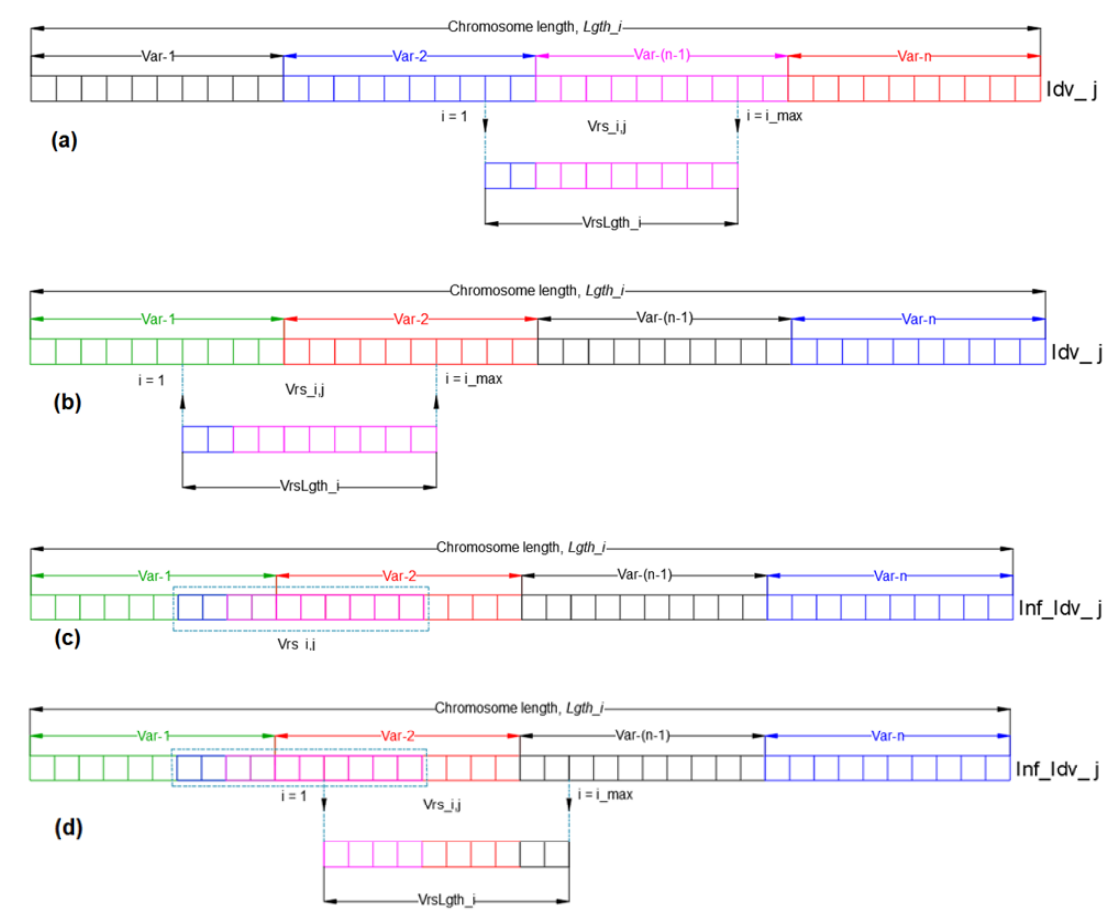
Figure 1. ( a ) Transduction operation for the creation of a virus individual, ( b ) reverse transcription operation for infecting an individual with a virus, ( c ) infected individual after the reverse transcription operation performed by the virus, and ( d ) partial transduction operation for changing the virus scheme.